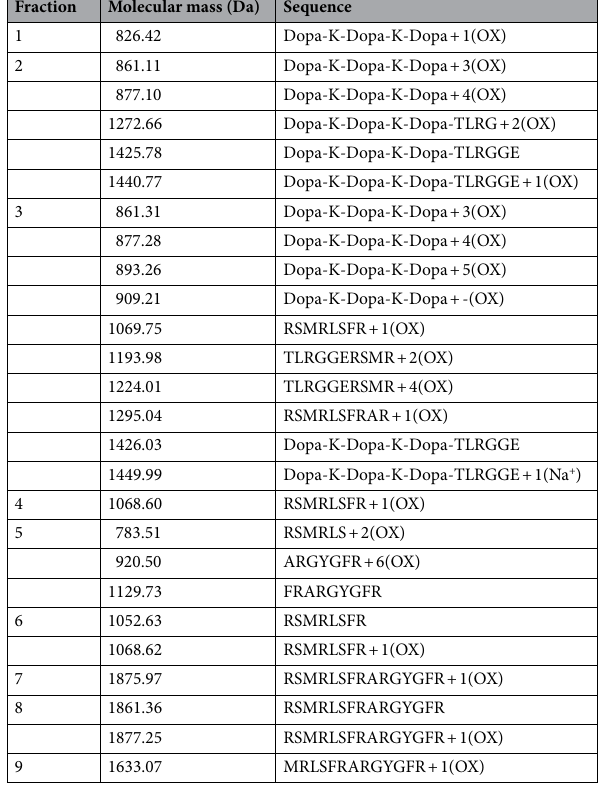
Table 3. Maldi-tof analysis of the 9 fractions obtained after HPLC of the digest of Dopa 5 T-Ctl by the endoprotease